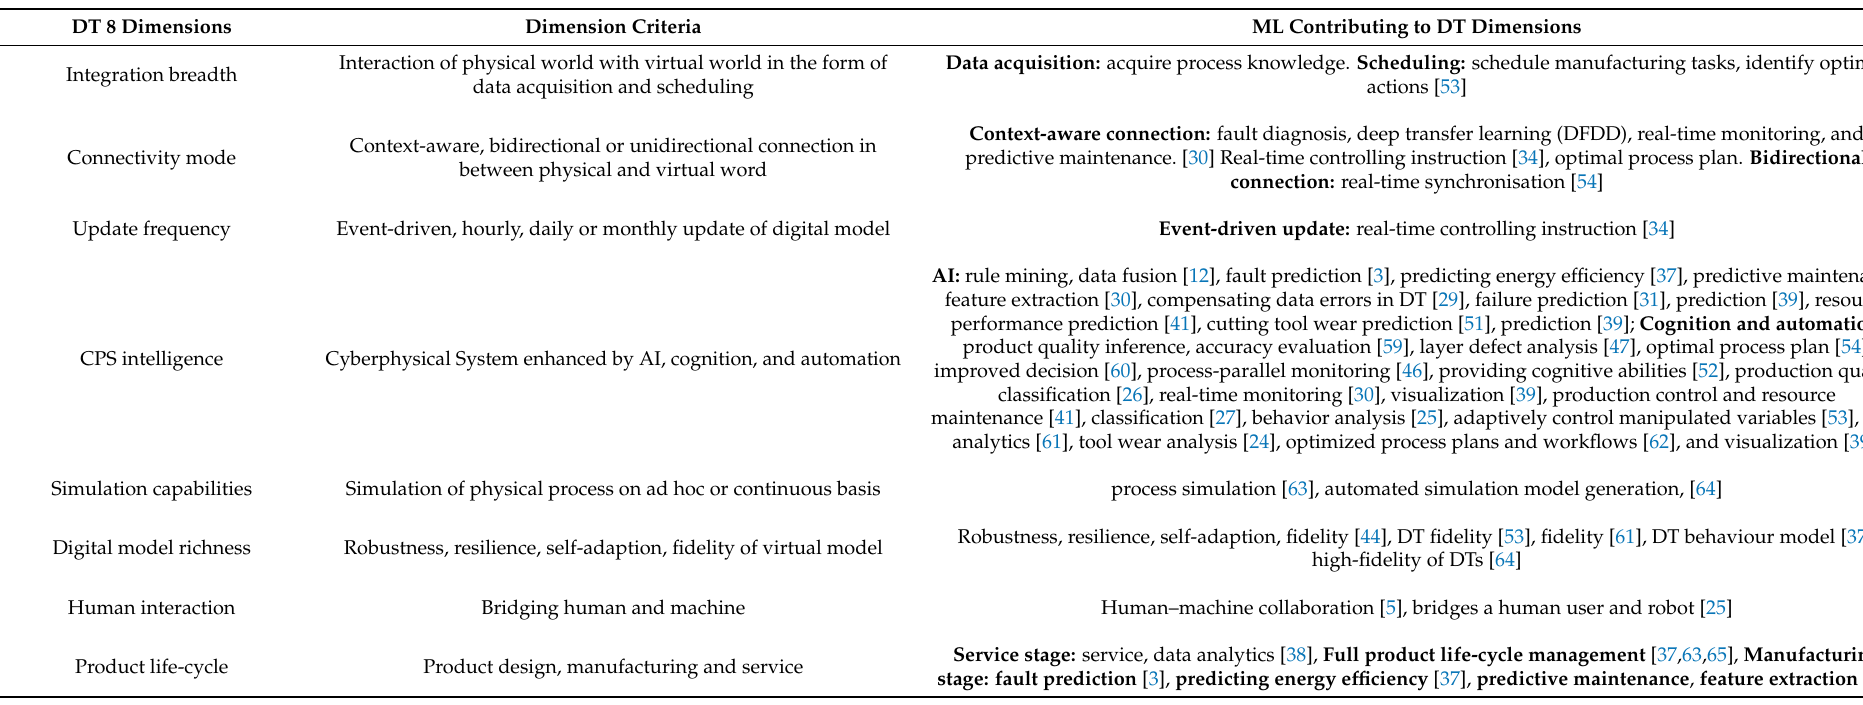
Table 2. ML contributing to DT